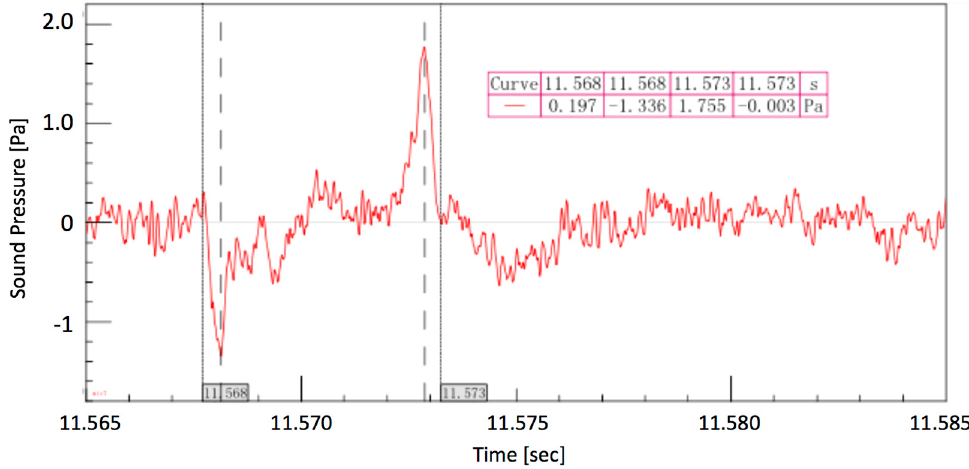
Figure 20. Noise characteristics in the time domain when lateral groove contacts ground (modified from Wei et al., 2016 [173], Figure 3).